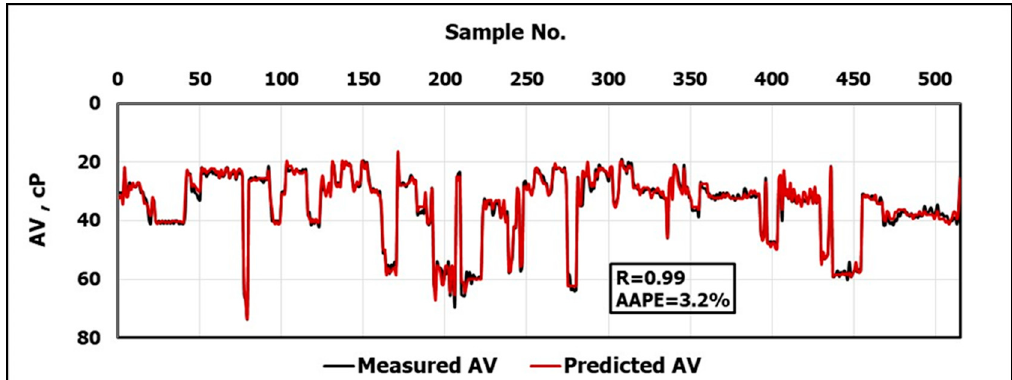
Figure 4. Measured 𝐴𝑉 vs. Predicted 𝐴𝑉 from the ANN model . Figure 4. Measured AV vs. Predicted AV from the ANN model.